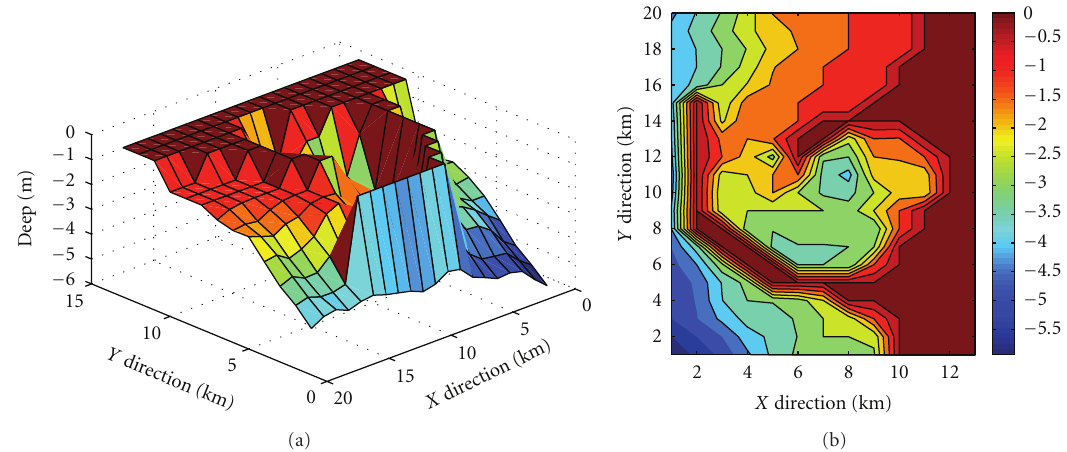
Figure 13: Grid map (a) and the bottom topography contour (b) of the breakwater area.